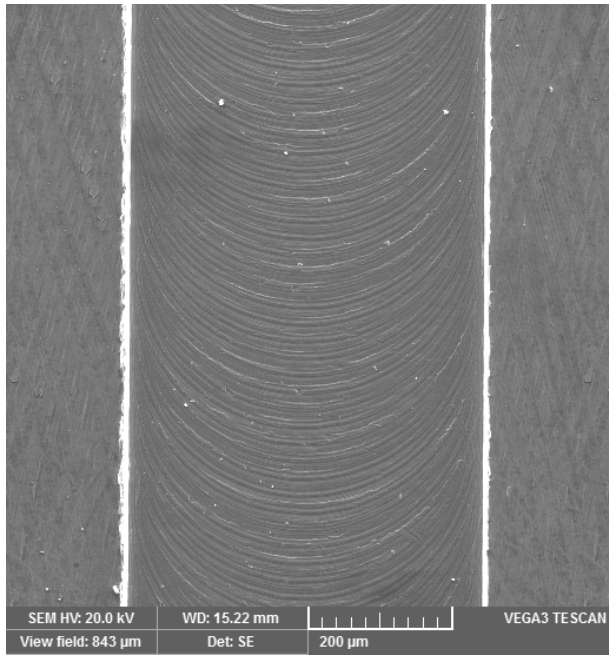
Figure 9. Minimum top burr width ( f z = 12µmtooth − 1 , V c = 10mmin − 1 , a p = 100µm).